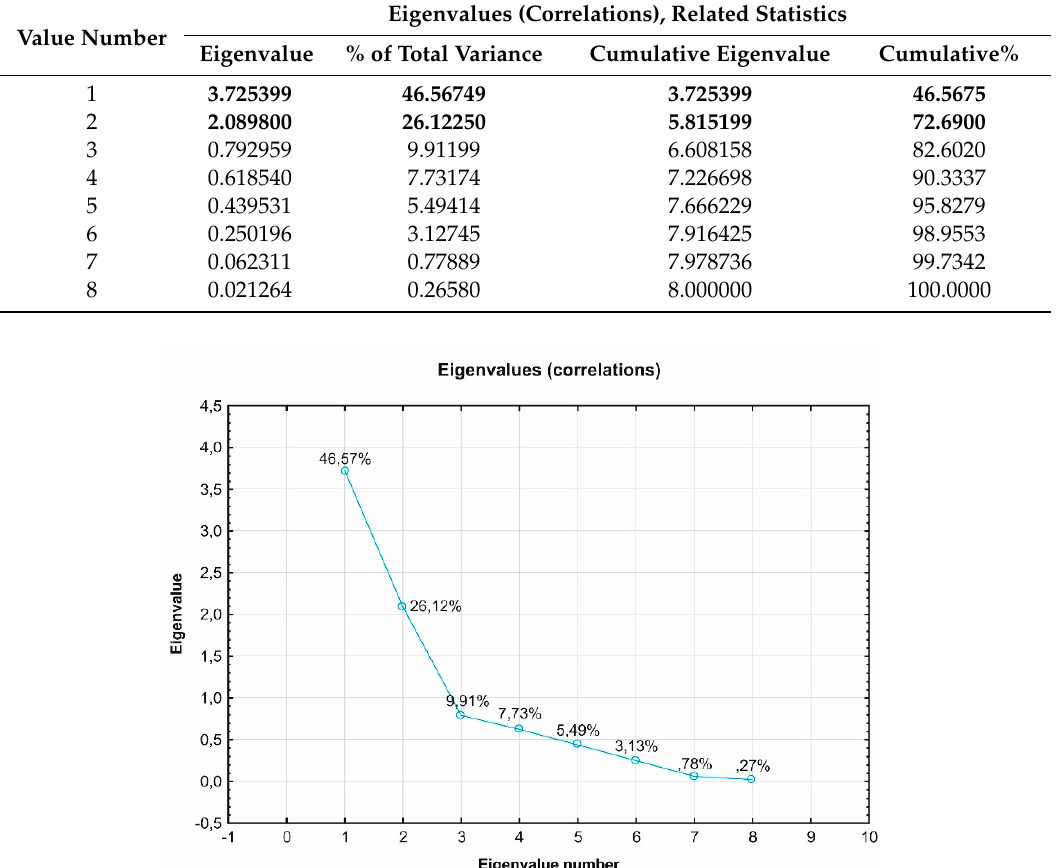
Table 5. Individual values of correlation matrix.